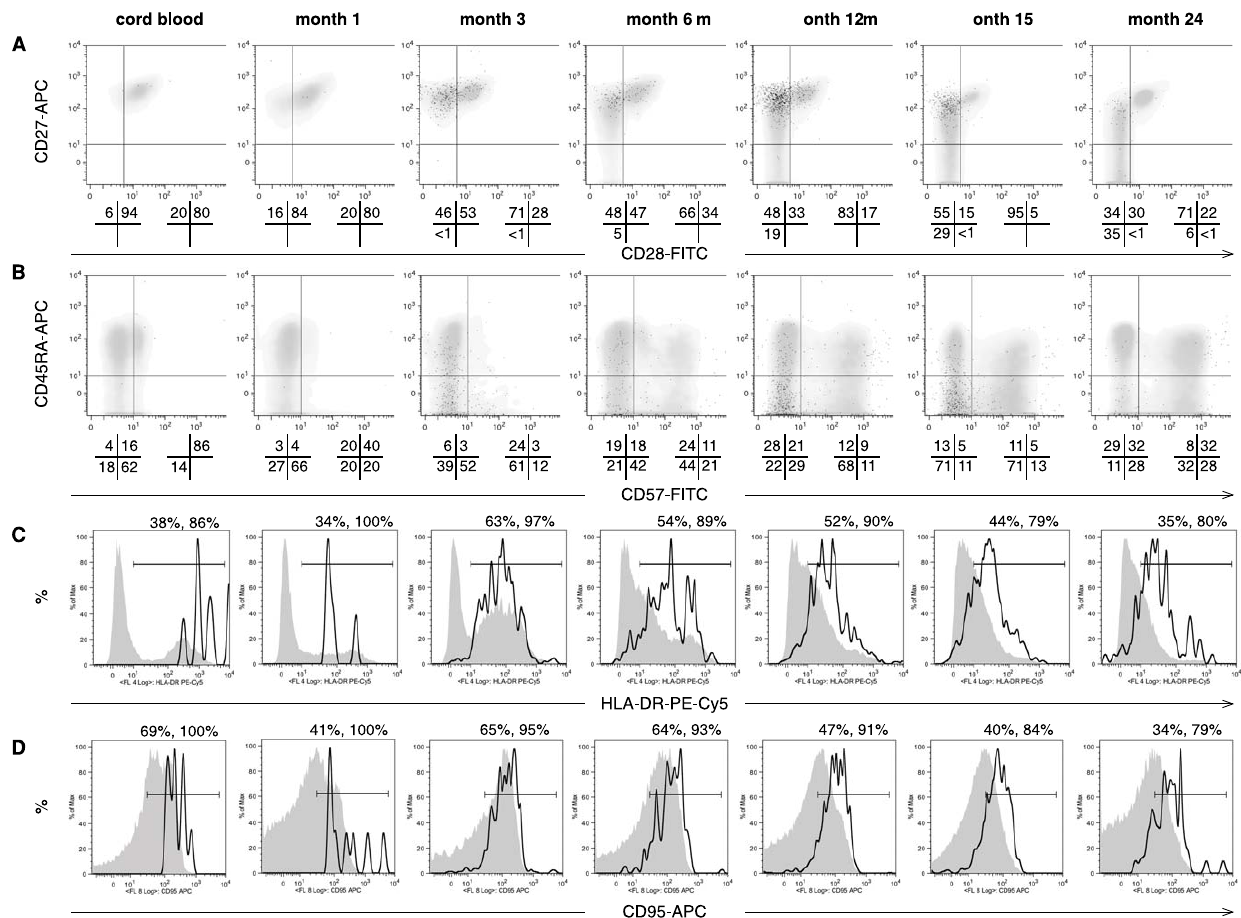
Figure 2. Differentiation of infant CD8 T cells during early and chronic infant HIV-1 infection. Dot plots and histograms show representative phenotyping during the first two years of life in subject B1-093, who was HIV-1 RNA positive at birth. Dot plots show A) CD27 and CD28 and B) CD45RA and CD57 staining. HIV-specific CD8 + T cells (gated on tetramer + /CD3 + CD8 + ) are shown as black dot plots overlaid on the overall CD8 + subset (gated on CD3 + CD8 + ), which are shown as density plots in gray. Quadrant statistics are shown below each dot plot, for the overall CD8 + (left diagram) and HIV-specific CD8 + T cell subsets (right diagram). Histograms show C) HLA-DR and D) CD95 staining, the overall CD8 + subset is shown by the solid gray histogram, and the HIV-specific CD8 + T cell subset is overlaid in black outline as an unshaded histogram. Histogram gate percentages are shown above the plots for the overall CD8 + , and HIV-specific CD8 + T cell subsets, respectively.